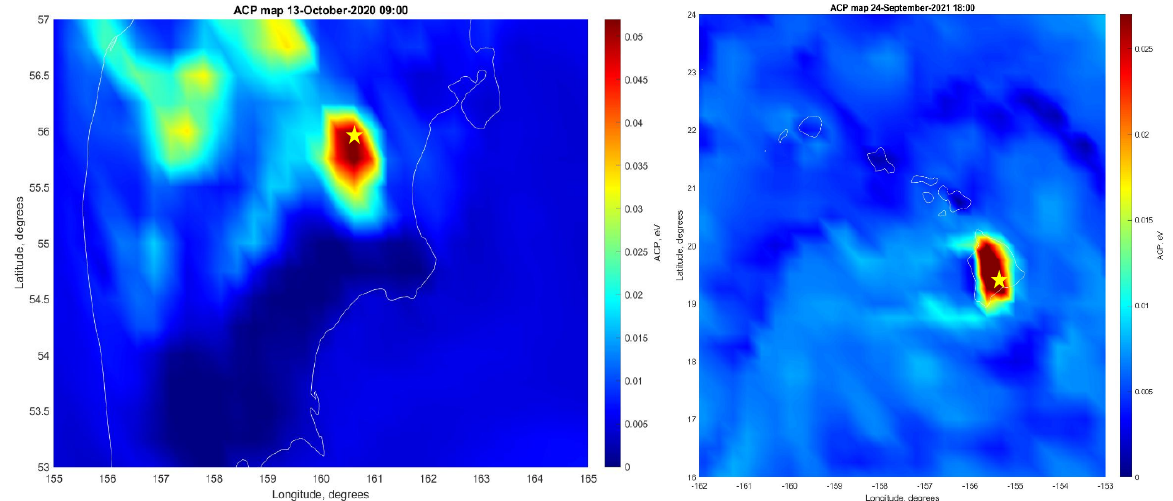
Figure 9. Left panel—spatial ACP distribution over the Bezymyanny volcano on 13 October 2020 at 09:00 UTC; right panel spatial ACP distribution over the K ī lauea volcano on 24 September 2021 at 18:00 UTC. The position of the volcano’s caldera is marked by the yellow star